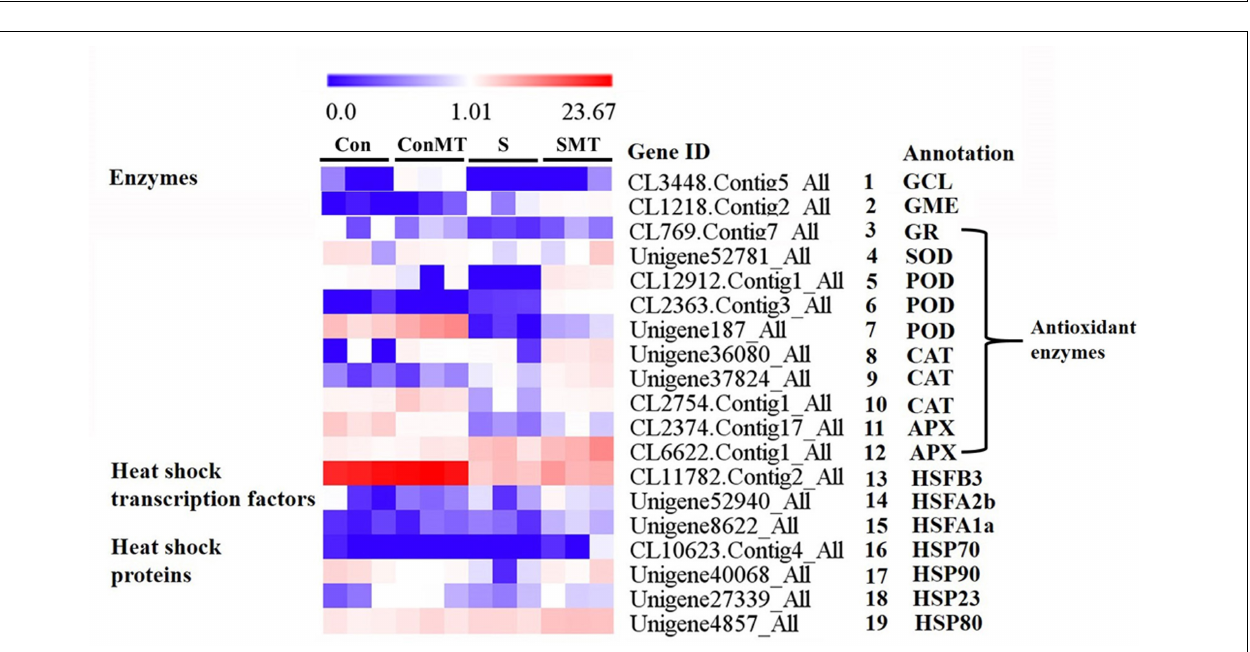
FIGURE 5 | Differentially expressed genes related to enzymes, heat shock transcription factors and heat shock proteins under heat stress in four comparisons. The bar indicates the expression (FPKM) of each gene in Con, ConMT, S, SMT as indicated by blue, white, and red squares. Blue and red represent low and high expression, respectively. Con, control; S, heat stress; SMT, heat stress with exogenous melatonin treatment; ConMT, control with exogenous melatonin treatment. More detailed information is shown in Supplementary Table 8 .